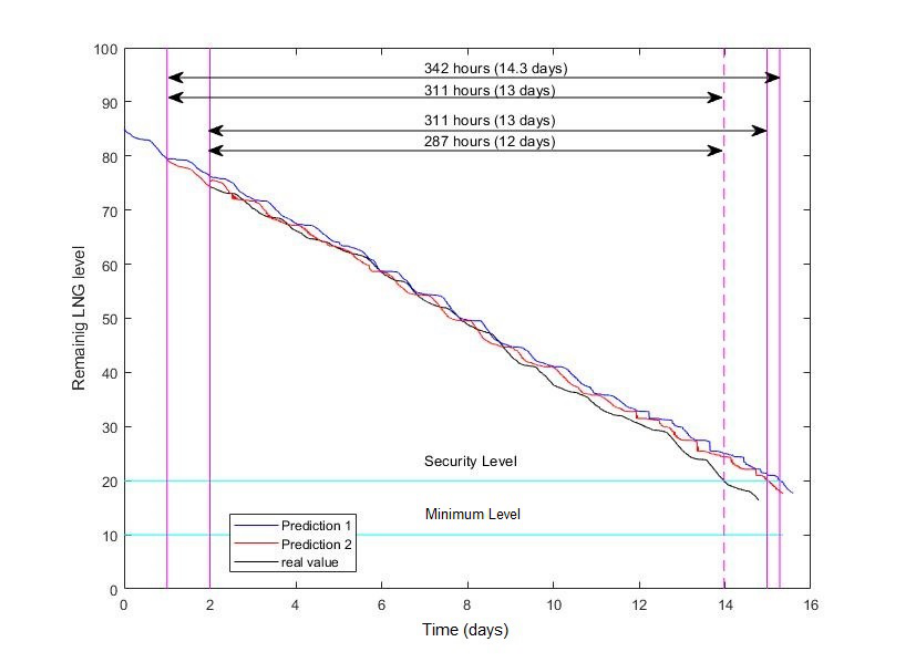
Figure 9. Prognosis stated at t = 1 day (blue) and at t = 2 days